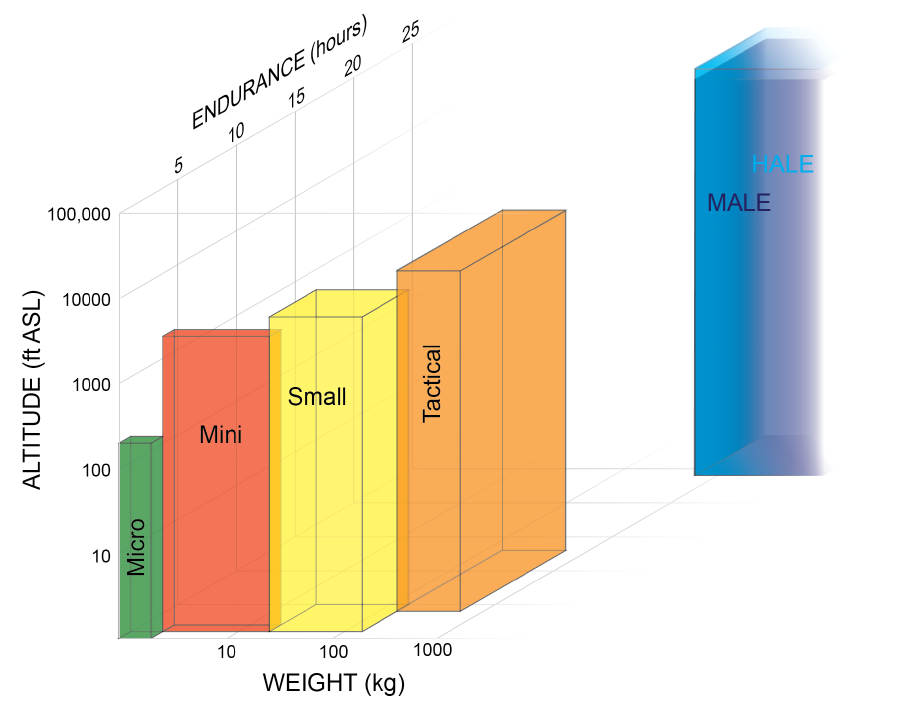
Figure 3. Classification of UAS according to the Department of